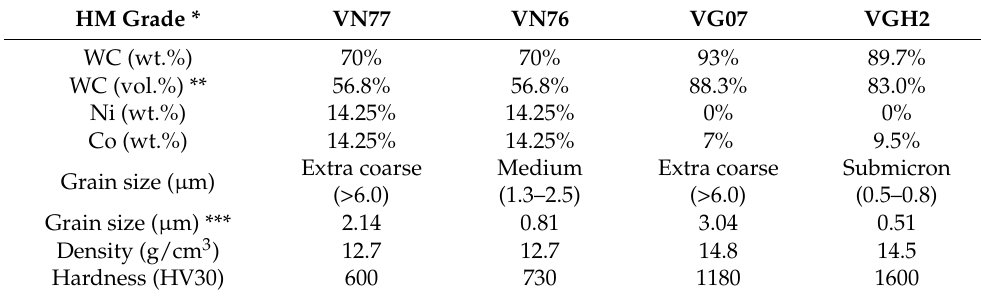
Table 2. Microstructural characteristics of the cemented carbide grades studied.